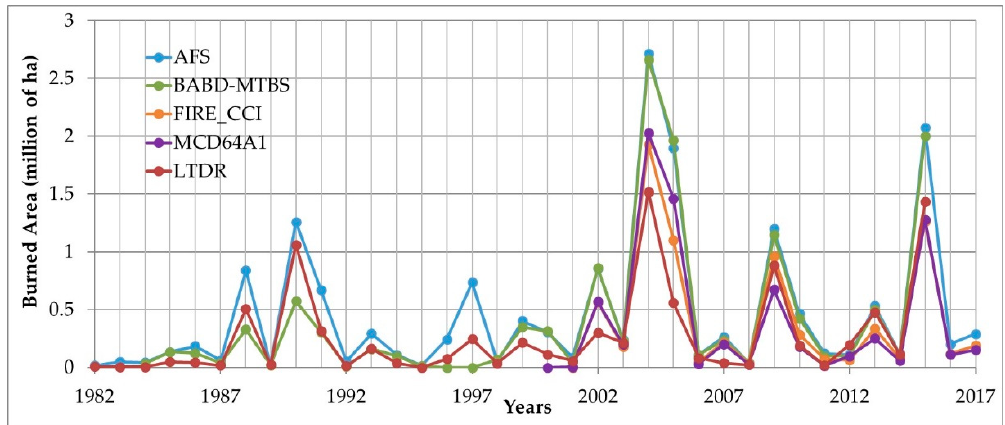
Figure 3. Burned area time series in the Alaskan boreal forests (1982–2017) from the Alaskan Fire Service, Burned Areas Boundaries Dataset - Monitoring Trends in Burn Severity (BABD-MTBS), Fire Climate Change Initiative (Fire_CCI) version 5.1, Moderate Resolution Imaging Spectroradiometer (MODIS) Direct Broadcast Monthly Burned Area Product Collection 6 (MCD64A1 C6), and burned area product from Long Term Data Record (BA-LTDR).